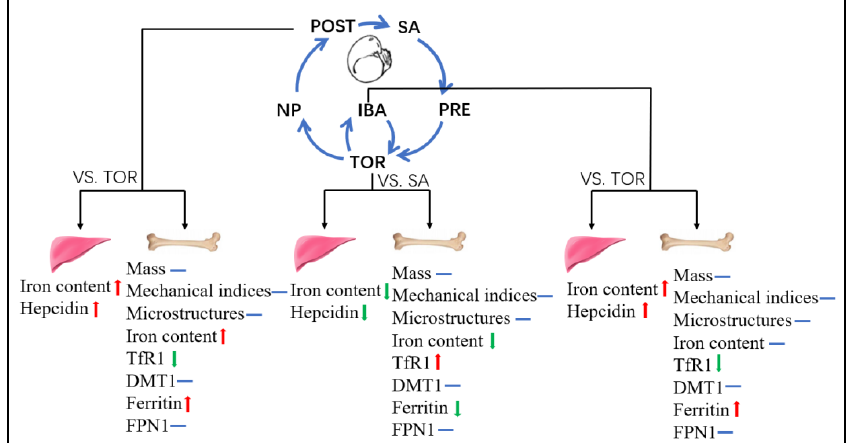
Figure 9. Plasticity changes in iron-metabolism-related indices during hibernation. (1) In TOR group (TOR vs. SA), iron content in liver and femur decreased, hepcidin expression decreased, iron storage capacity in the femur decreased, and iron absorption capacity increased; (2) In IBA group (IBA vs. TOR), iron content and hepcidin expression in the liver increased, and iron storage capacity in the femur increased; (3) In POST group (POST vs. TOR), iron content in the liver and femur increased (recovery), and hepcidin expression increased; iron storage capacity in the femur increased, and iron absorption capacity decreased. SA, summer active group; PRE, pre-hibernation group; TOR, torpor group; IBA, interbout arousal group; NP, near post-hibernation group; and POST, post-hibernation group. Note: red arrow indicates up-regulation, green arrow indicates down-regulation, and blue line indicates no significant